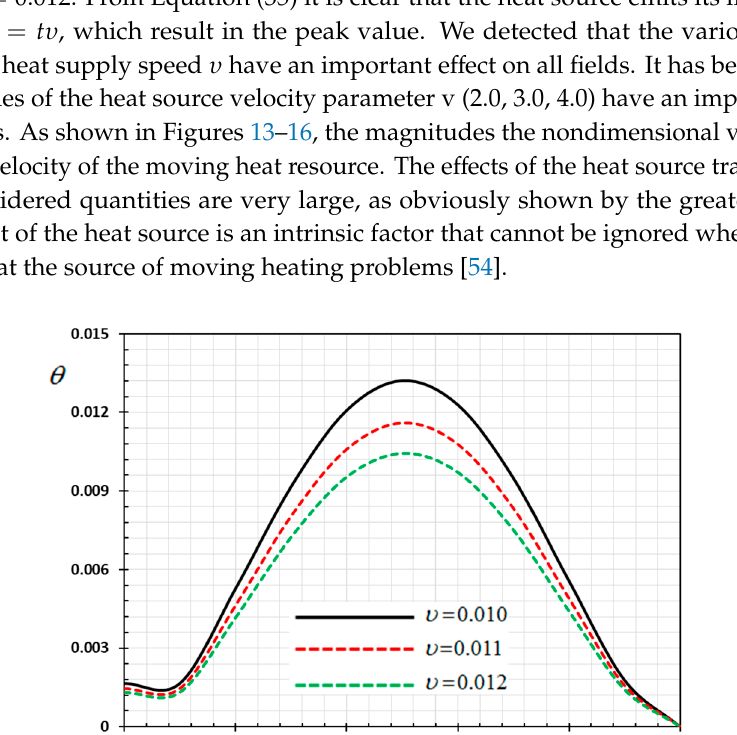
Figure 14. Variation of displacement 𝑤 versus 𝑧 for different gradient coefficient 𝑁 .